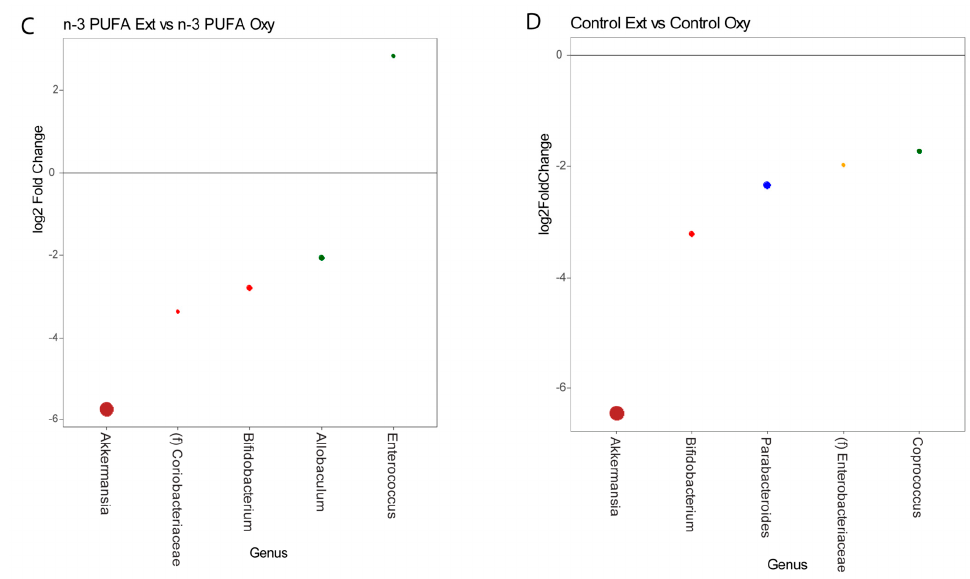
Figure 4. Di ff erential abundance of microbes di ff ered by n-3 PUFA supplementation and opioid extinction. ( A ) E ff ects of n-3 PUFA on genera abundance during oxycodone maintenance. DESeq2 models were used to identify di ff erentially abundant genera ( q < 0.05) in the n-3 PUFA supplementation group, combining data from D1-OXY and D10-OXY and adjusting for the time point. Di ff erences are expressed as a log2 fold change, with the dot size proportional to the mean genera abundance across samples and the dot color indicative of phylum. ( B ) E ff ects of n-3 PUFA on genera abundance during opioid extinction found using DESeq2 analysis of combined 1E and 2E data, adjusted for phase. ( C ) E ff ects of opioid extinction on genera abundance while on n-3 PUFA supplementation. ( D ) E ff ects of opioid extinction on genera abundance while on a control